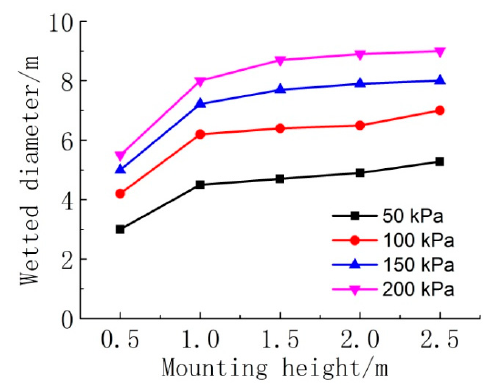
Figure 12. Calculated wetted diameters for an in-motion sprinkler with different working pressures and mounting heights.